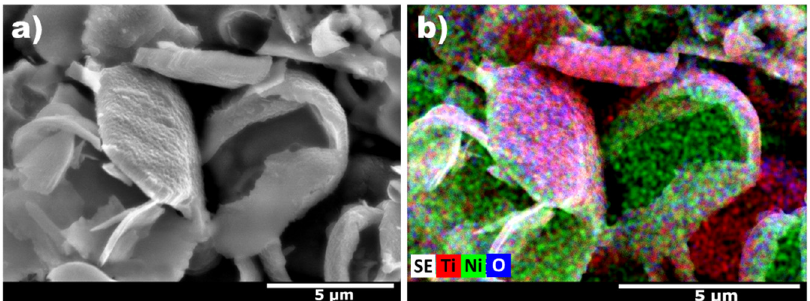
Figure 9. C-TiO 2 +Ni MP powder after 20 consecutive RhB solution bleaching cycles: ( a ) SEM image; and ( b ) EDS elemental mapping.